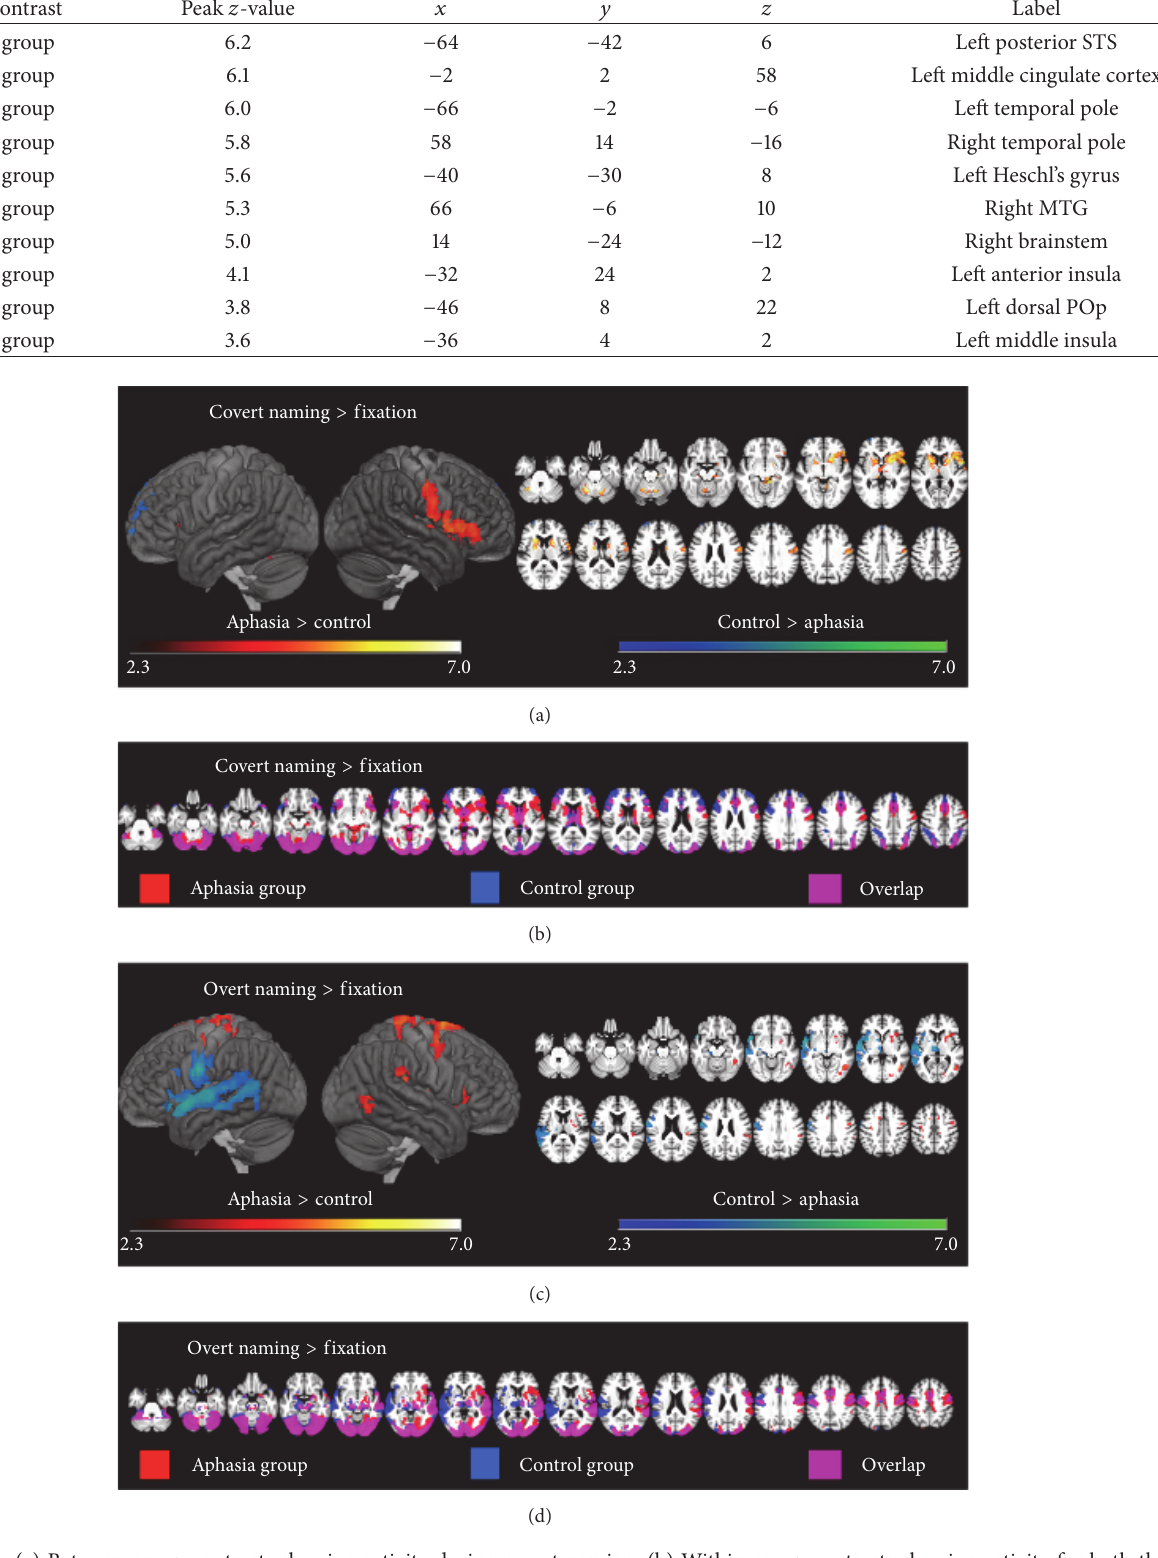
Figure 1: (a) Between-group contrasts showing activity during covert naming. (b) Within-group contrasts showing activity for both the aphasia and control groups during covert naming. (c) Between-group contrasts showing activity during overt naming. (d) Within-group contrasts showing activity for both the aphasia and control groups during overt